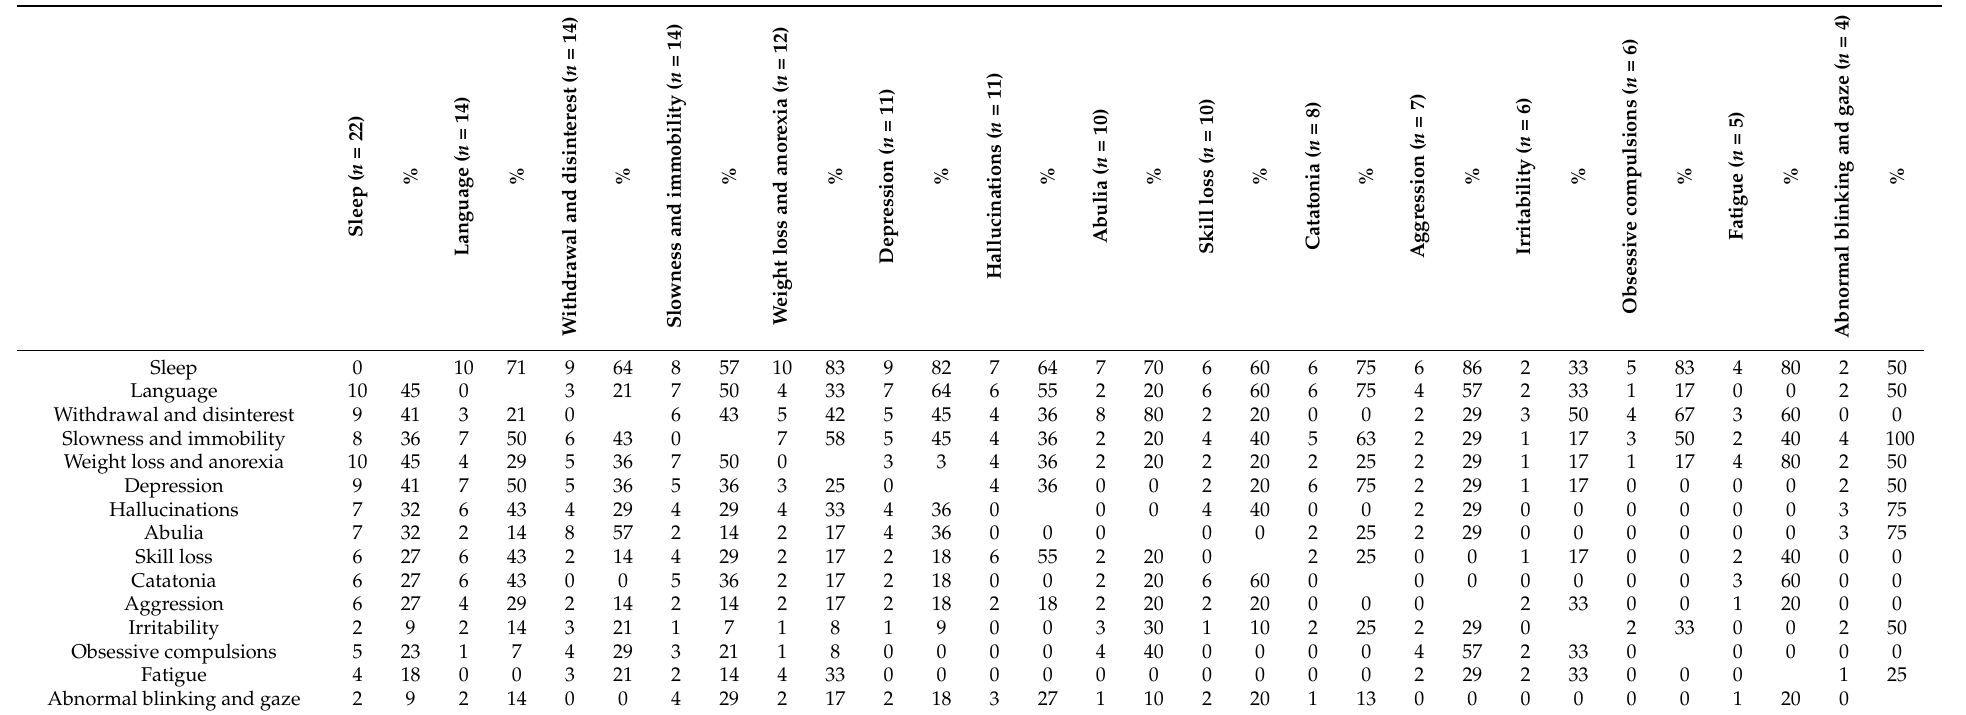
Table A2. Table showing co-presentation of symptoms in Group A